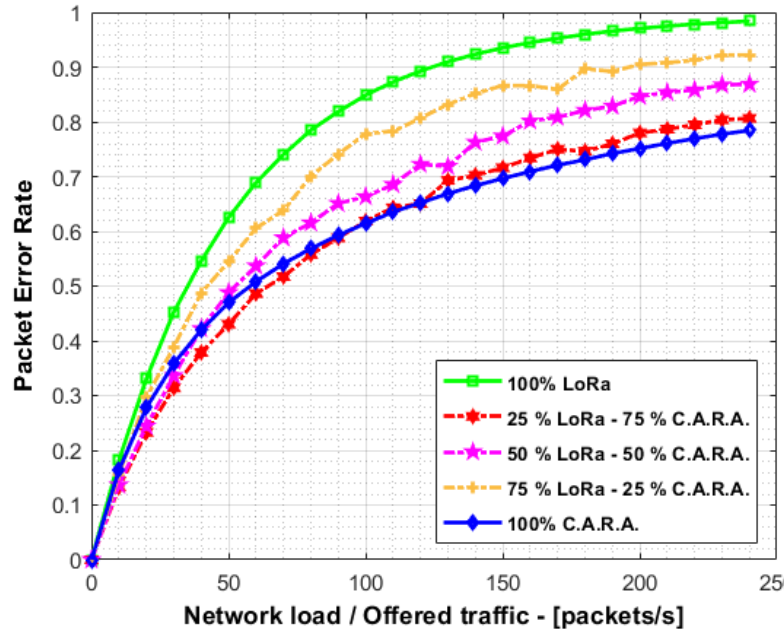
Figure 12. PER comparison coexistence LoRaWAN vs.